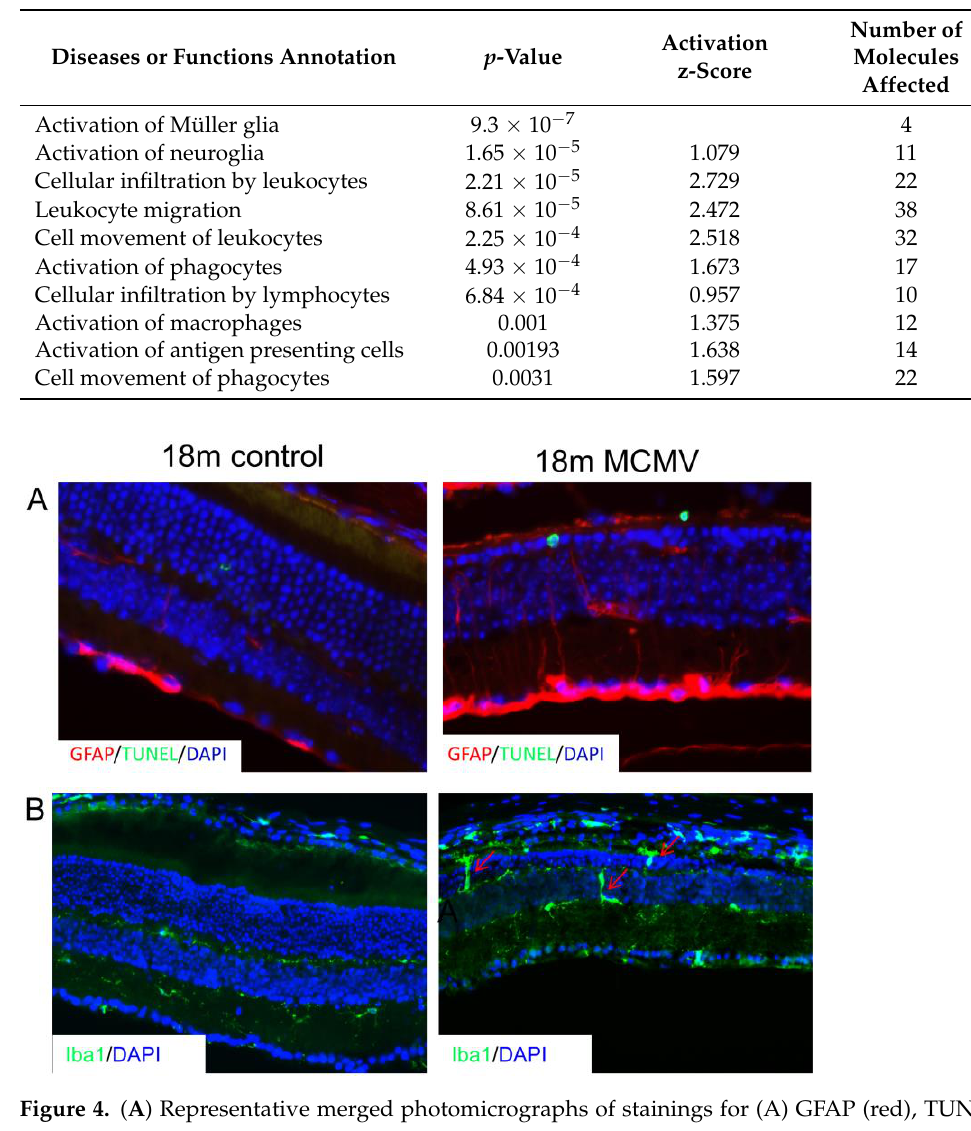
Table 5. Immune cells and glia.